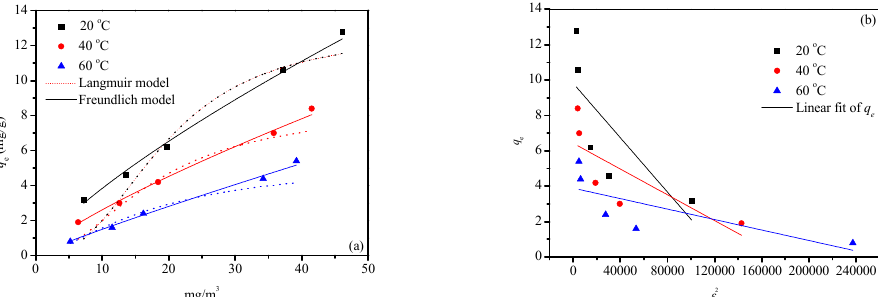
Figure 5. Adsorption isotherms of formaldehyde (HCHO) on CGC at 20, 40, and 60 °C. ( a ) the dotted lines are Langmuir model; the solid lines are Freundlich model; and, ( b ) D-R model.